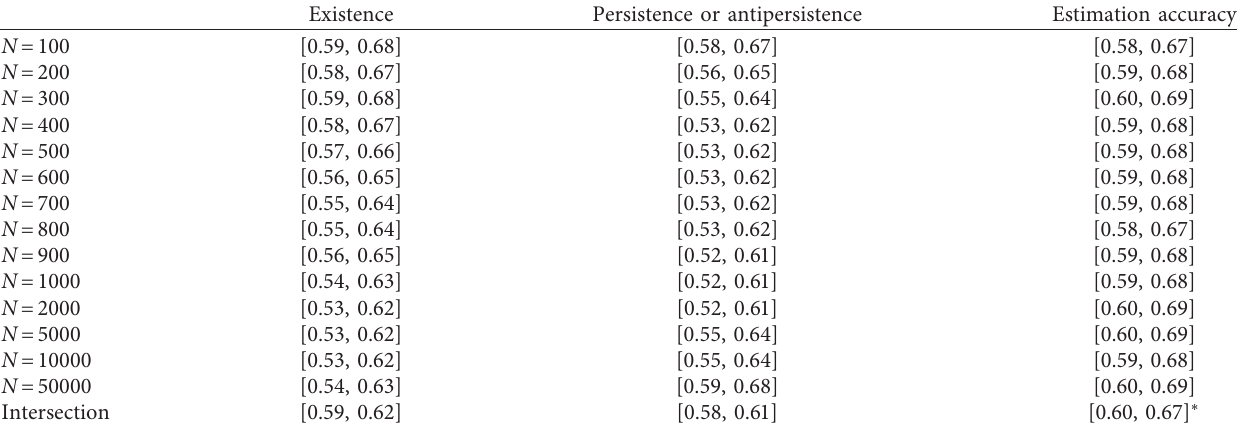
Table 1: The optimal bandwidth parameter range under different sequence lengths.